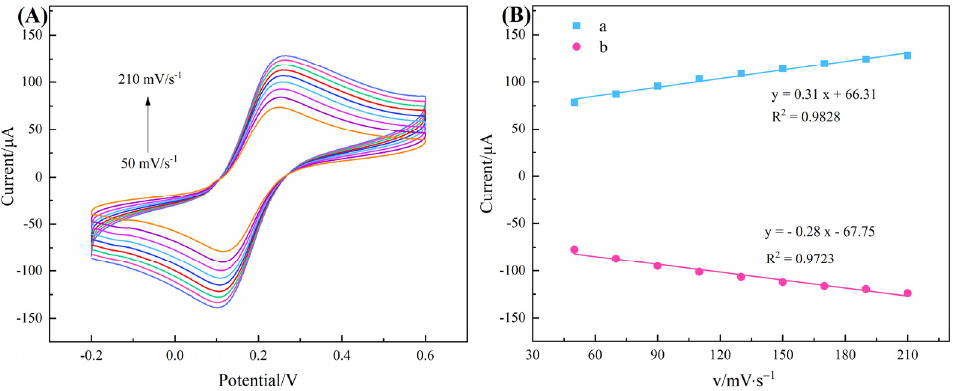
Figure 5. ( A ) CV of PAA-MWCNTs-Ag-SCS/GCE at scan rates of 50, 70, 90, 110, 130, 150, 170, 190, and 210 mV/s. ( B ) Linear dependence between scan rate and peak current (anodic (a) and cathodic